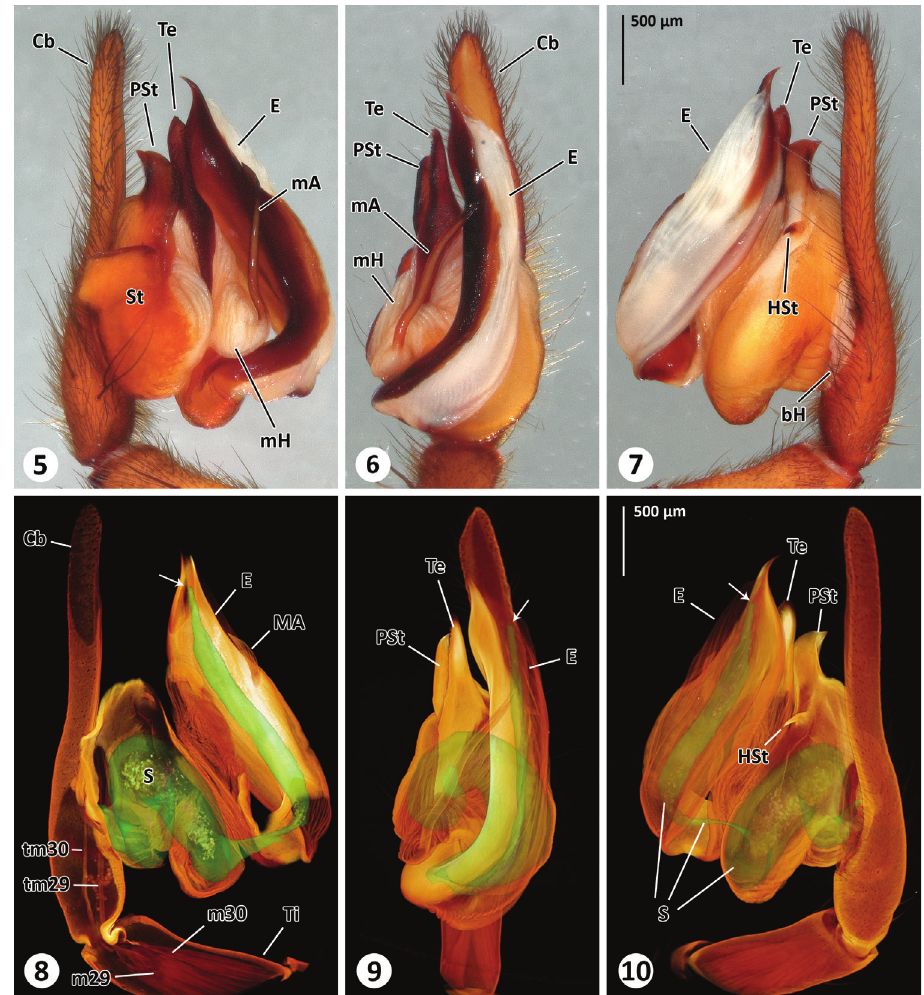
Figure 5–10. Left male palp of Thaida chepu . 5–7 extended focal plane images of male palp in prolat- eral ( 5 ), ventral ( 6 ) and retrolateral ( 7 ) view 8–10 surface model of the spermophor superimposed on the volume rendering of the male palp to illustrate dimension and shape of the spermophor. The views correspond to Figs 5–7 . The cymbium, subtegulum and tegulum are (partly) removed in Fig. 8 to show tendons and muscles. The arrows point to the opening of the